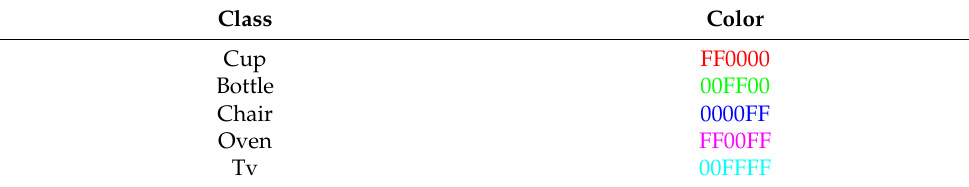
Table 2. Classes of objects used in the mapping process, with their associate colors. Class Color Cup FF0000